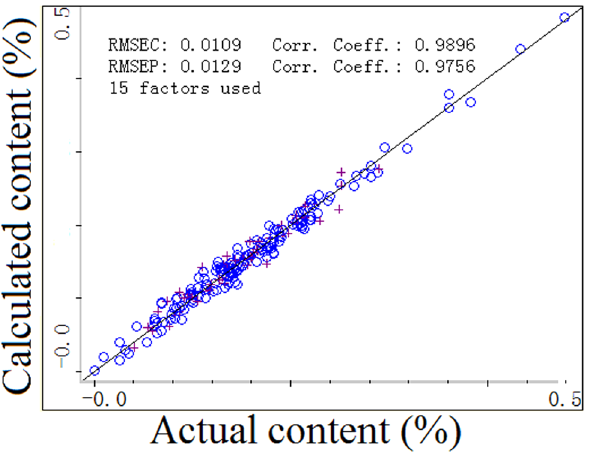
Figure 7: Predicted content versus actual content. The blue circle and the red plus represented the calibration set and validation set,